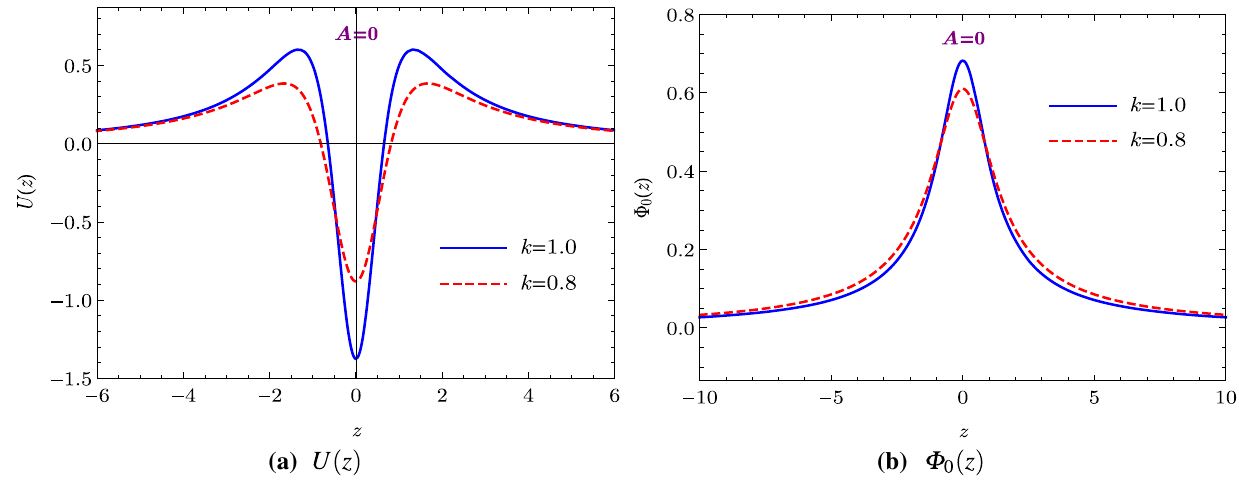
Fig. 5 The profiles of the effective potential U ( z ) and gravitational zero mode (cid:19) 0 ( z ) for the case of A =